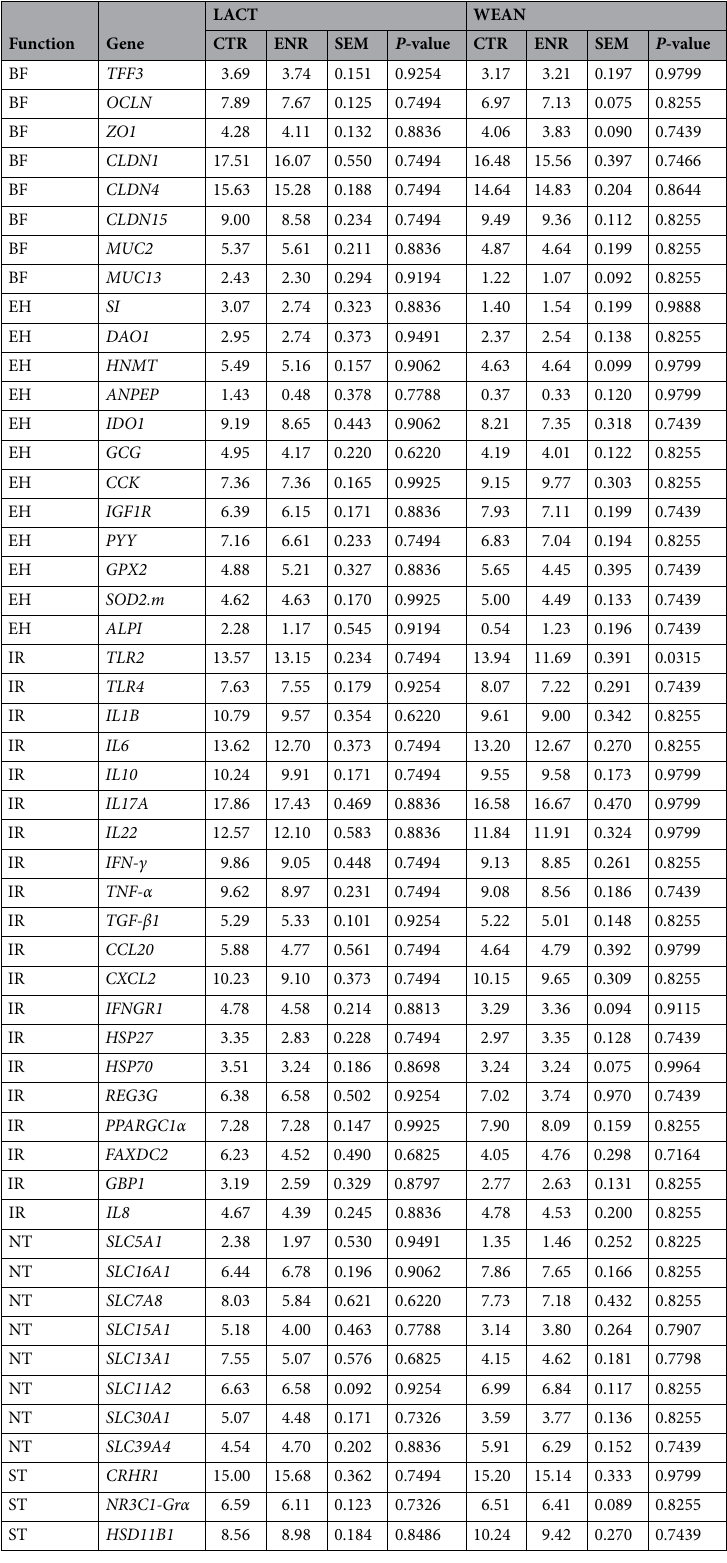
Table 1. Mean DCrt results obtained for the 51 genes that could be quantitatively determined, both during lactation and after weaning for CTR and ENR piglets. Details for the different genes can be found in Supplementary Table S4. (BF: Barrier function related genes/EH: Enzymes/Hormones related genes/IR: Immune system related genes/NT: Nutrient Transport related genes/ST: Stress related